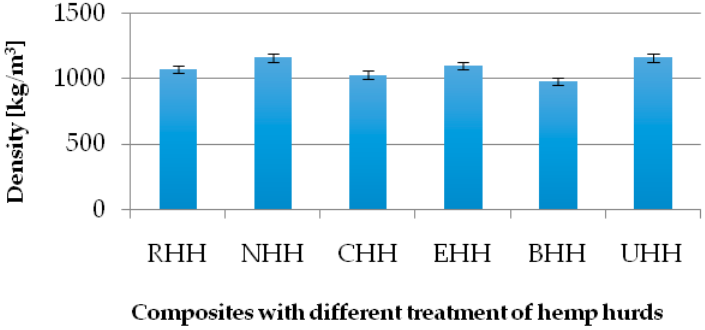
Figure 2. Bulk density values of original and treated hemp composites after 28 days of hardening.